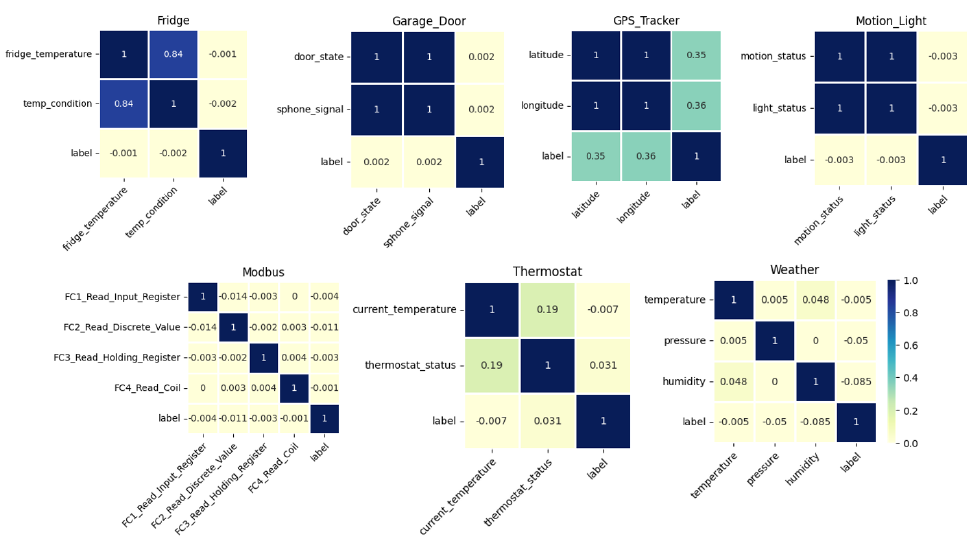
Figure 1. IoT device feature and label correlation.